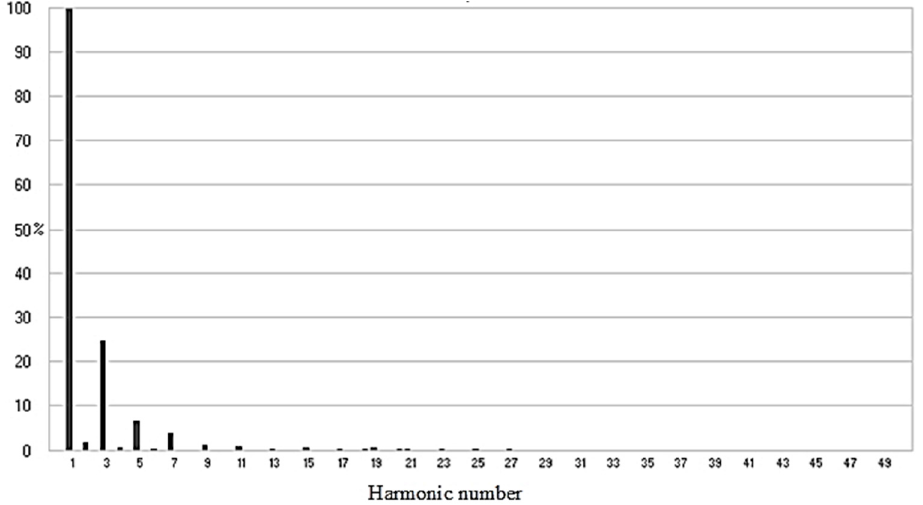
Figure 8. Set of household equipment: harmonic spectrum and current total harmonic distortion factor. THD I = 25.7%.